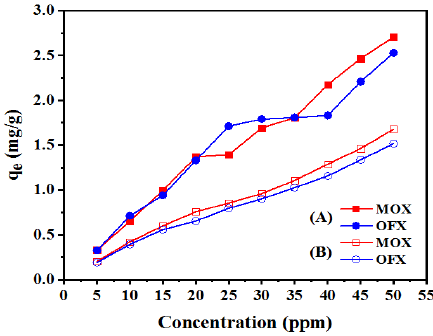
Figure 10. MOX and OFX adsorption on ( A ) Met-GO/SA (Adsorption conditions: time = 140 min; temperature = 35 ◦ C; and adsorbent dosage = 0.25 g) and ( B ) GO/SA (Adsorption conditions: time = 200 min; temperature = 35 ◦ C; and adsorbent dosage = 0.4 g).